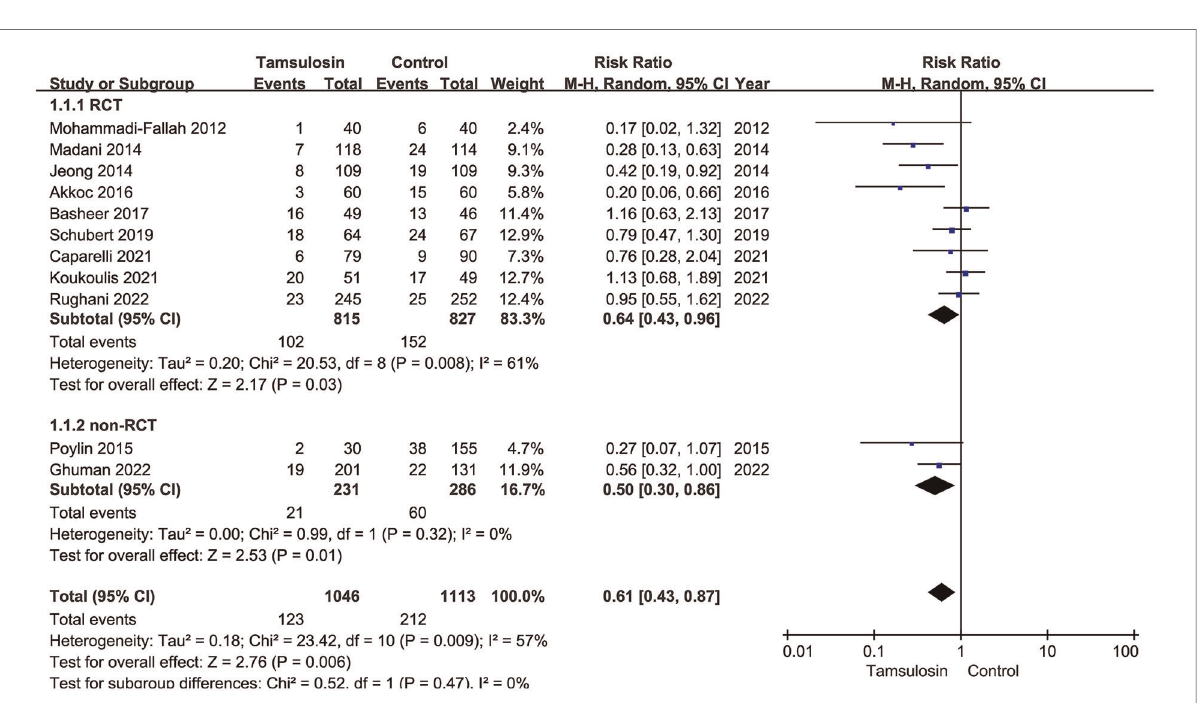
FIGURE 8 Subgroup analysis of the rate of POUR based on the level of